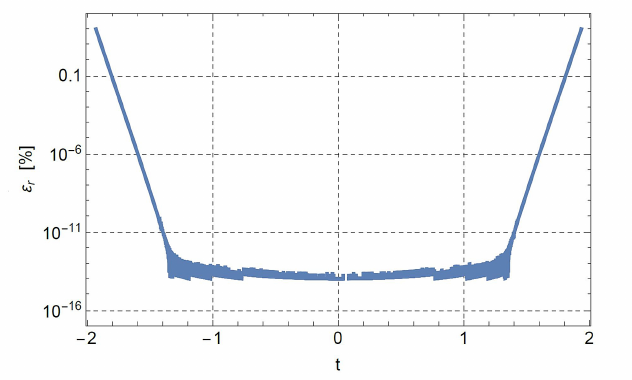
Figure 5. Relative percentage error of the Bell’s approximation of F ( t ) in (28). The table containing the first few moments of the considered function F ( t ) , as com- puted using the Gauss–Kronrod quadrature rule (G-KQR), µ k , and the proposed Bell’s method, ˜ µ k , is reported in Figure 6.